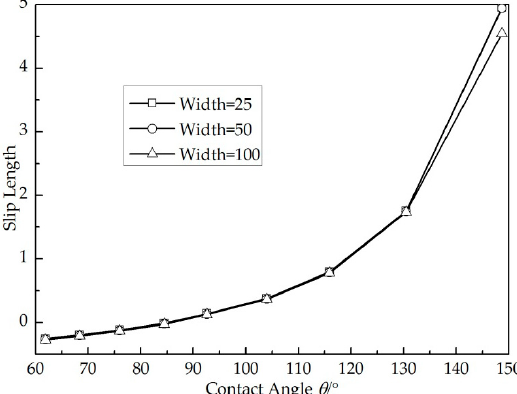
Figure 8. Slip length versus contact angle.